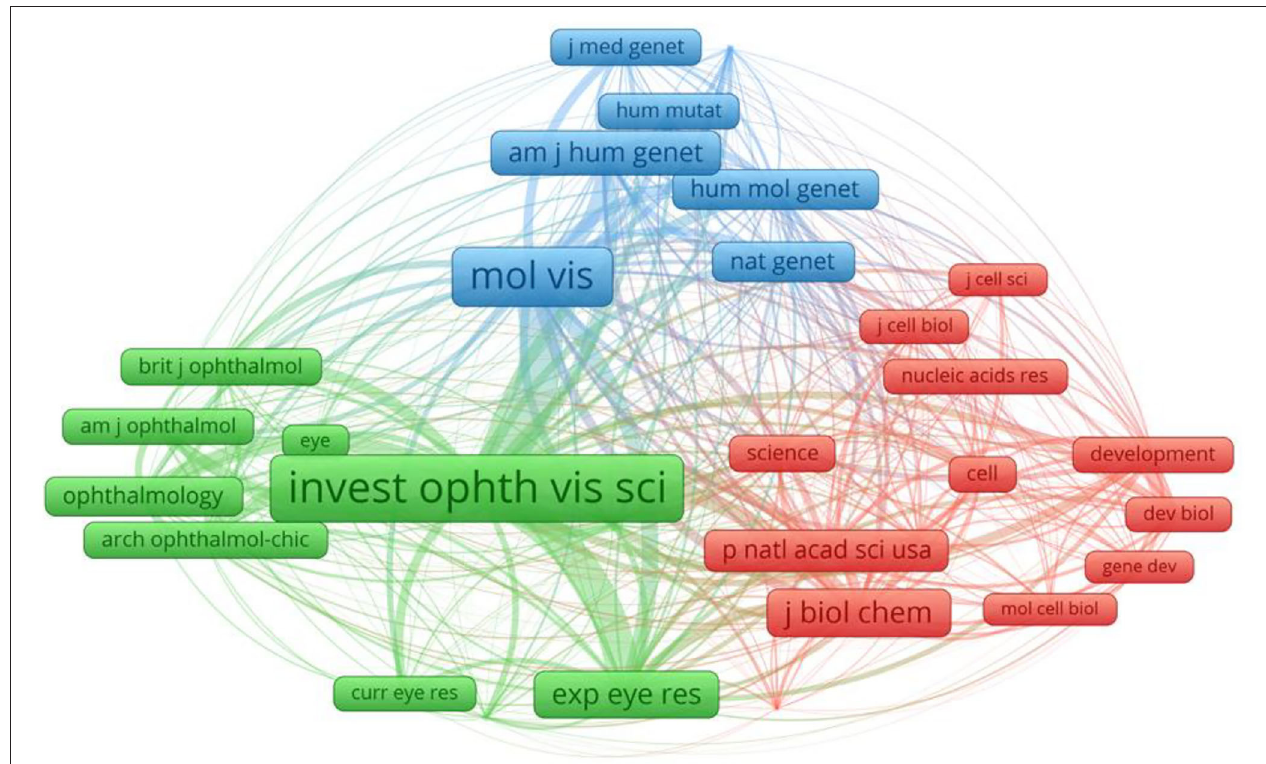
FIGURE 5 | The network map of cited journals contributed to publications on Cataract-gene from 2010 to 2019.